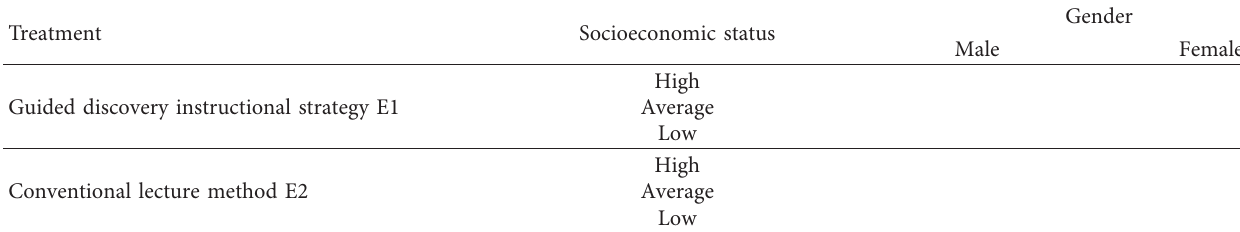
Table 1: 2x3x2 factorial